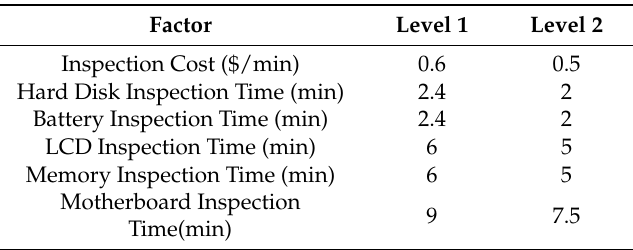
Table 3. Inspection cost and time